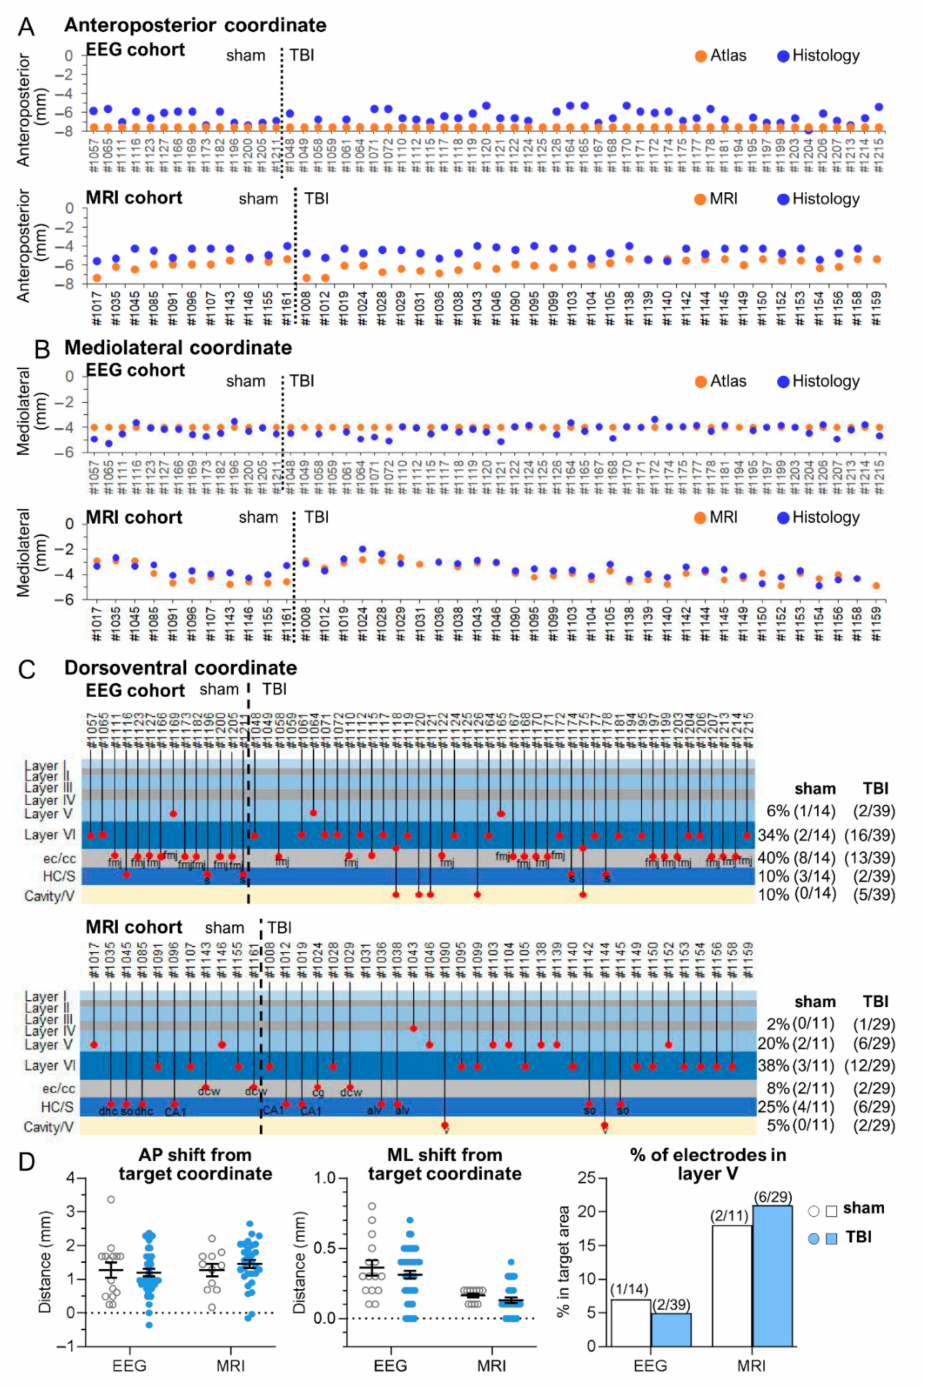
Figure 5. Posterior intracortical electrode—schematic representations of the atlas-based, histological, and MRI-guided coordinates in each rat of the EEG and MRI cohorts. ( A ) Anteroposterior (AP) coor- dinate. In the EEG cohort ( n = 47, electrode operation right after injury), the fixed atlas-based target AP coordinate of − 7.56 mm from the bregma was applied to implant the electrodes (orange dots). In the MRI cohort ( n = 40, electrode operation at 5 months postinjury), the target AP coordinate was individually determined using the in vivo 5-month T2-weighted MR images. The target coordinate fluctuated depending on the TBI (traumatic brain injury)-induced lesion extent. Note a mild anterior shift ( y -axis) in the histologically verified “true” AP coordinate (blue dots) relative to the